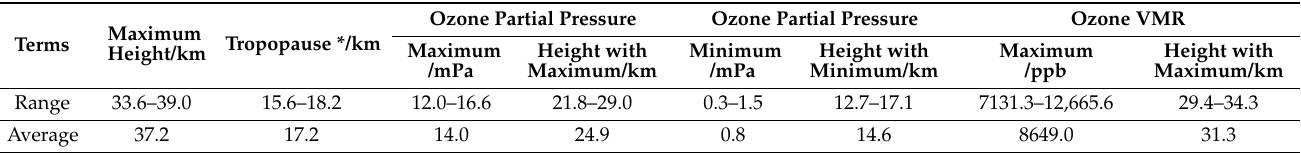
Table 1. Overview of the 12 ozone sounding tests at Shaowu station in the winter of